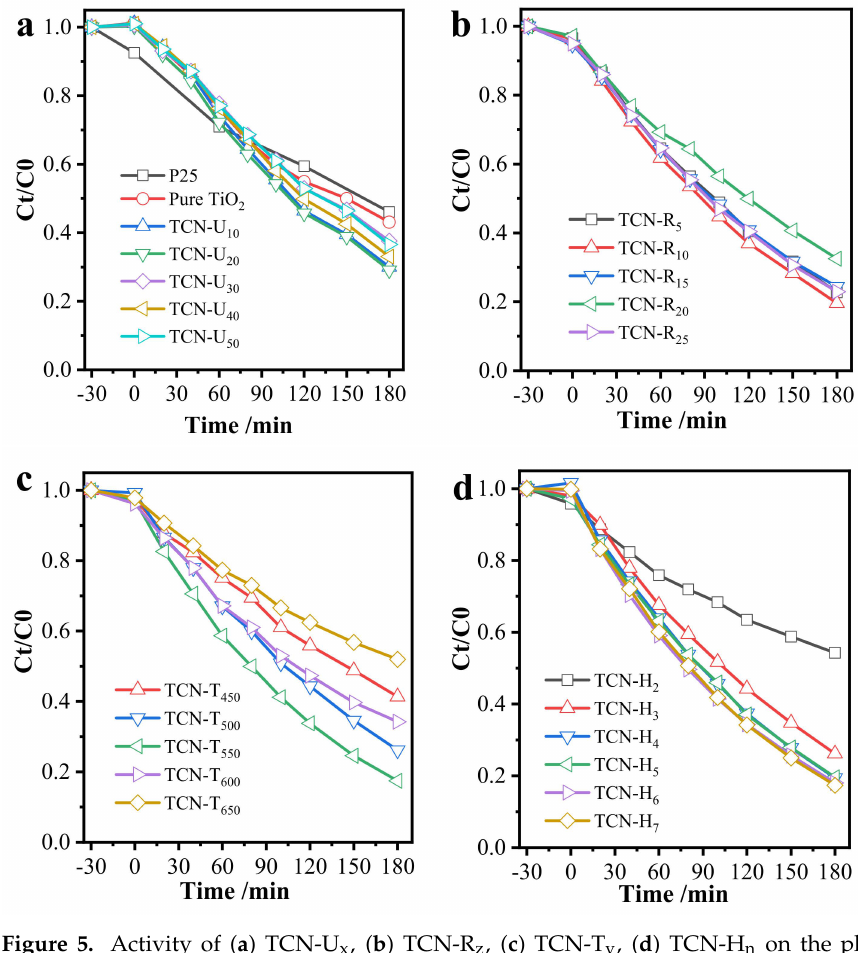
Figure 5. Activity of ( a ) TCN-U x , ( b ) TCN-R z , ( c ) TCN-T y , ( d ) TCN-H n on the photocatalytic degradation of AAF.